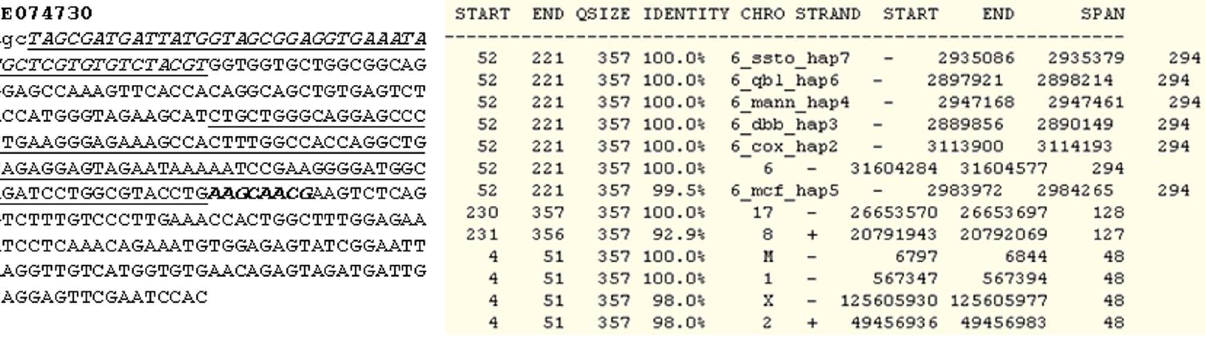
Figure 3. BE074730 is a trimera. The origin of its 4–51st nt sequence (italicized and underlined) is unclear because it is completely matched not only to mtDNA but also to an NUMT on chromosome 1, as shown in the table copied from the UCSC browser. Its 52–221st nt sequence consists of two exons of the PRRC2A (also called BAT2) mRNA, with the downstream exon underlined; its real genomic origin is unclear, because this nRNA sequence belongs to a cluster of genes on chromosome 6 as shown in the table. The 230–357th nt sequence of this EST is part of the TMEM97 mRNA from chromosome 17. Actually, the 4–51st sequence also has homolog on chromosomes 2 and X, while the 230–357th sequence has homolog on chromosome 8. There is an 8-nt (boldfaced and italicized AAGCAACG) unmatchable gap between the 2nd and the 3rd partners.